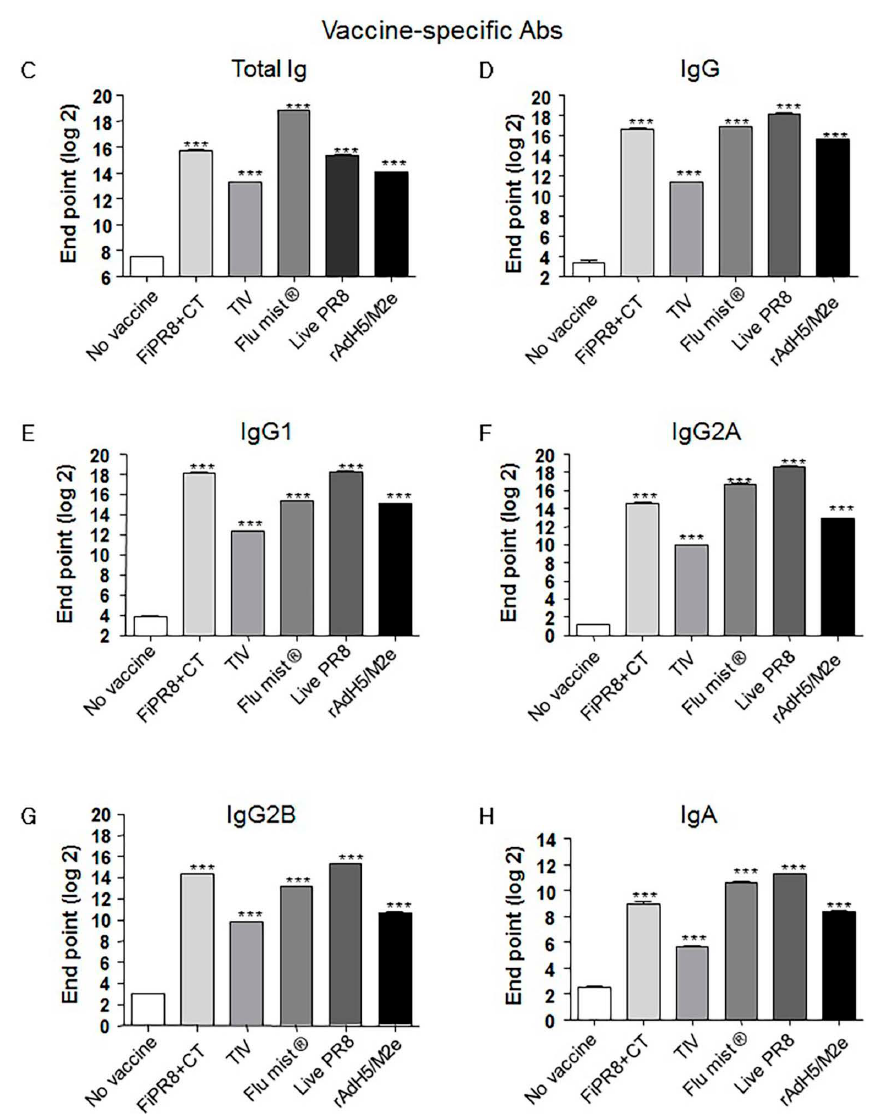
Figure 1. Adenovirus-vectored influenza vaccine induces a balanced T helper (Th)1/Th2 neutralizing antibody response. Balb/c mice were immunized with formaldehyde-inactivated PR8+CT (FiPR8+CT), live PR8 (H1N1), TIV, FluMist ® or, rAdH5/M2e. Four weeks post-immunization, sera were collected and the hemagglutination inhibiting (HI) titers ( A ), virus neutralization titers ( B ), and vaccine-specific total Ig, IgG, IgG1, IgG2A, IgG2B, and IgA antibodies ( C – H ) were determined. HI and VN titer of FiPR8+CT, TIV, Flu mist, and Live PR8 were tested against H1N1 and rAdH5/M2e was tested against H5N2. The values represent the mean ± SEM (vertical bars) of end point ELISA antibody titers determined from 5 mice per group (*** p <